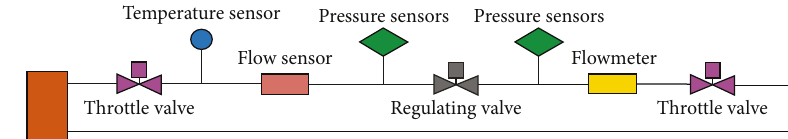
Figure 3: Schematic diagram of the control valve flow test system.